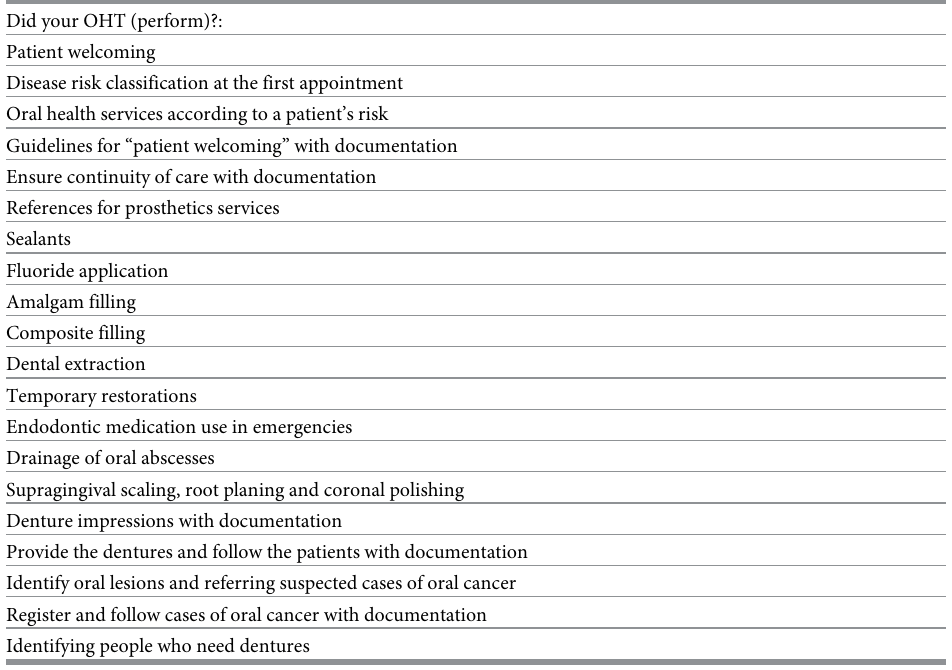
Table 1. Questions about dental procedures in PHC used for creating a rating grade–OHT performance. Did your OHT